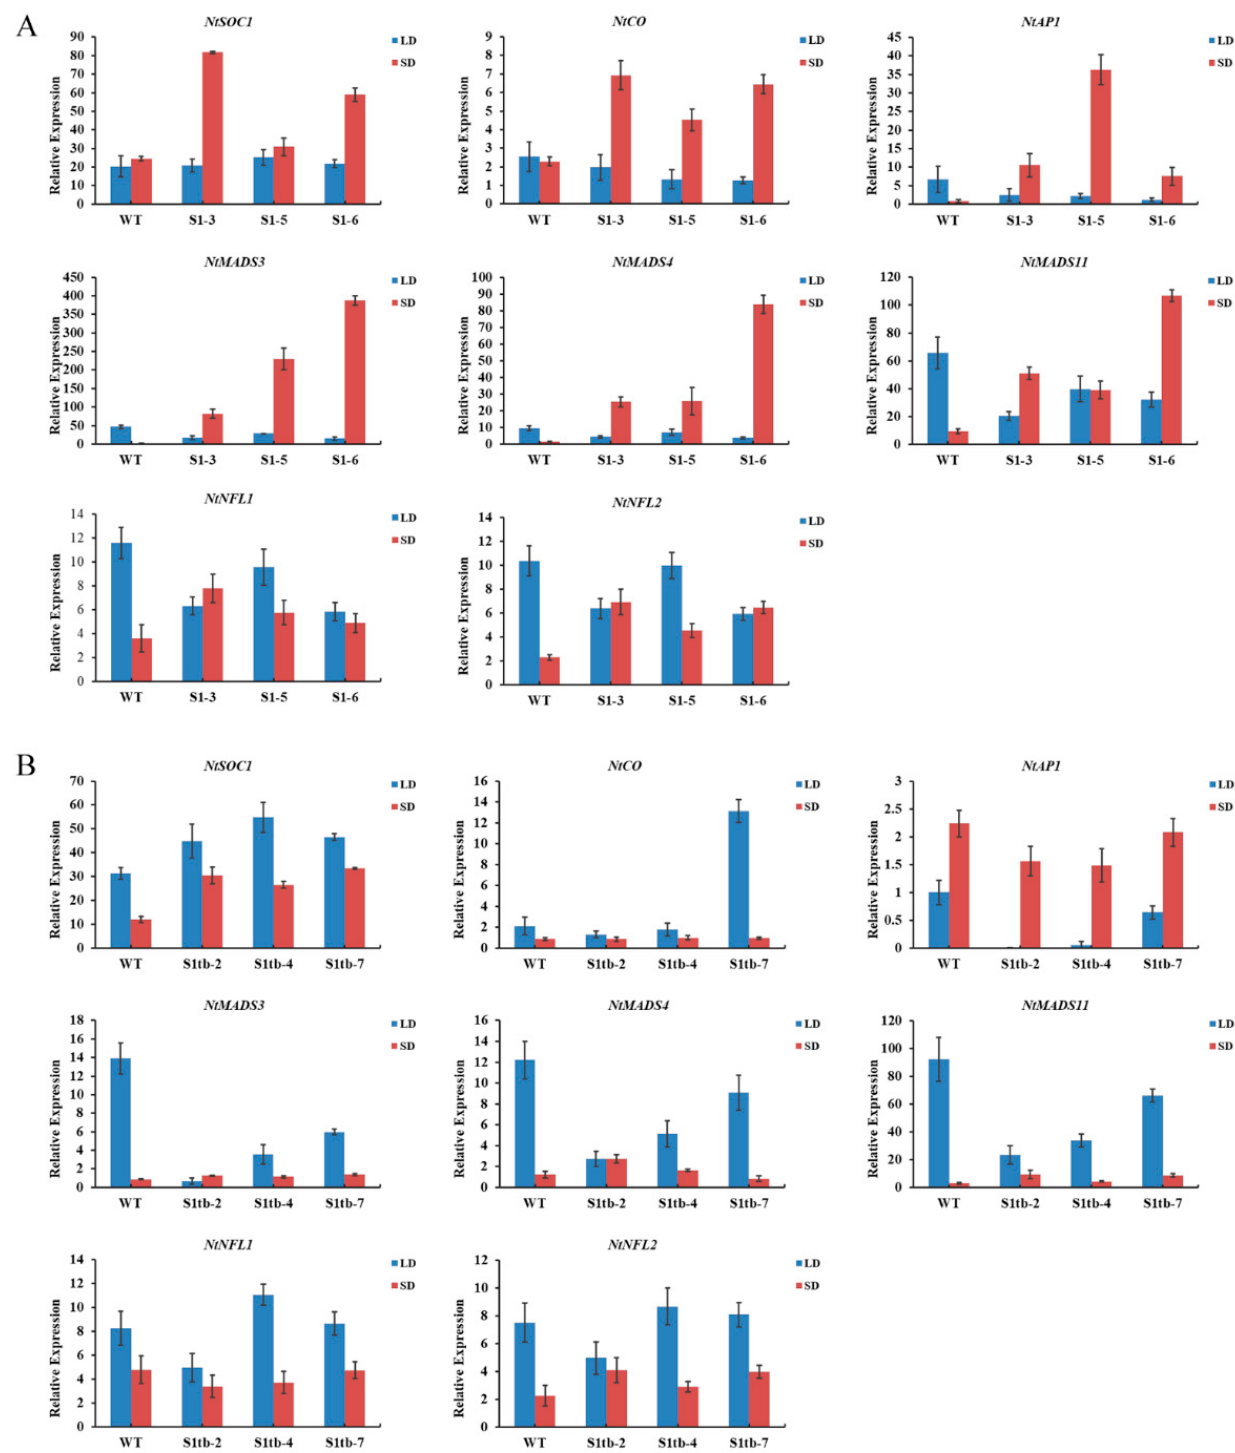
Figure 7. The relative expression of endogenous flowering-related genes in PmSBP1 and PmSBP1tb transgenic tobacco under long and short conditions. ( A ) The expression of flowering-related genes in PmSBP1 transgenic tobacco. S1-3, S1-6, and S1-7 were three transgenic lines. ( B ) The expression of flowering-related genes in PmSBP1tb transgenic tobacco. S1tb-2, S1tb-4, and S1tb-7 were three transgenic lines.